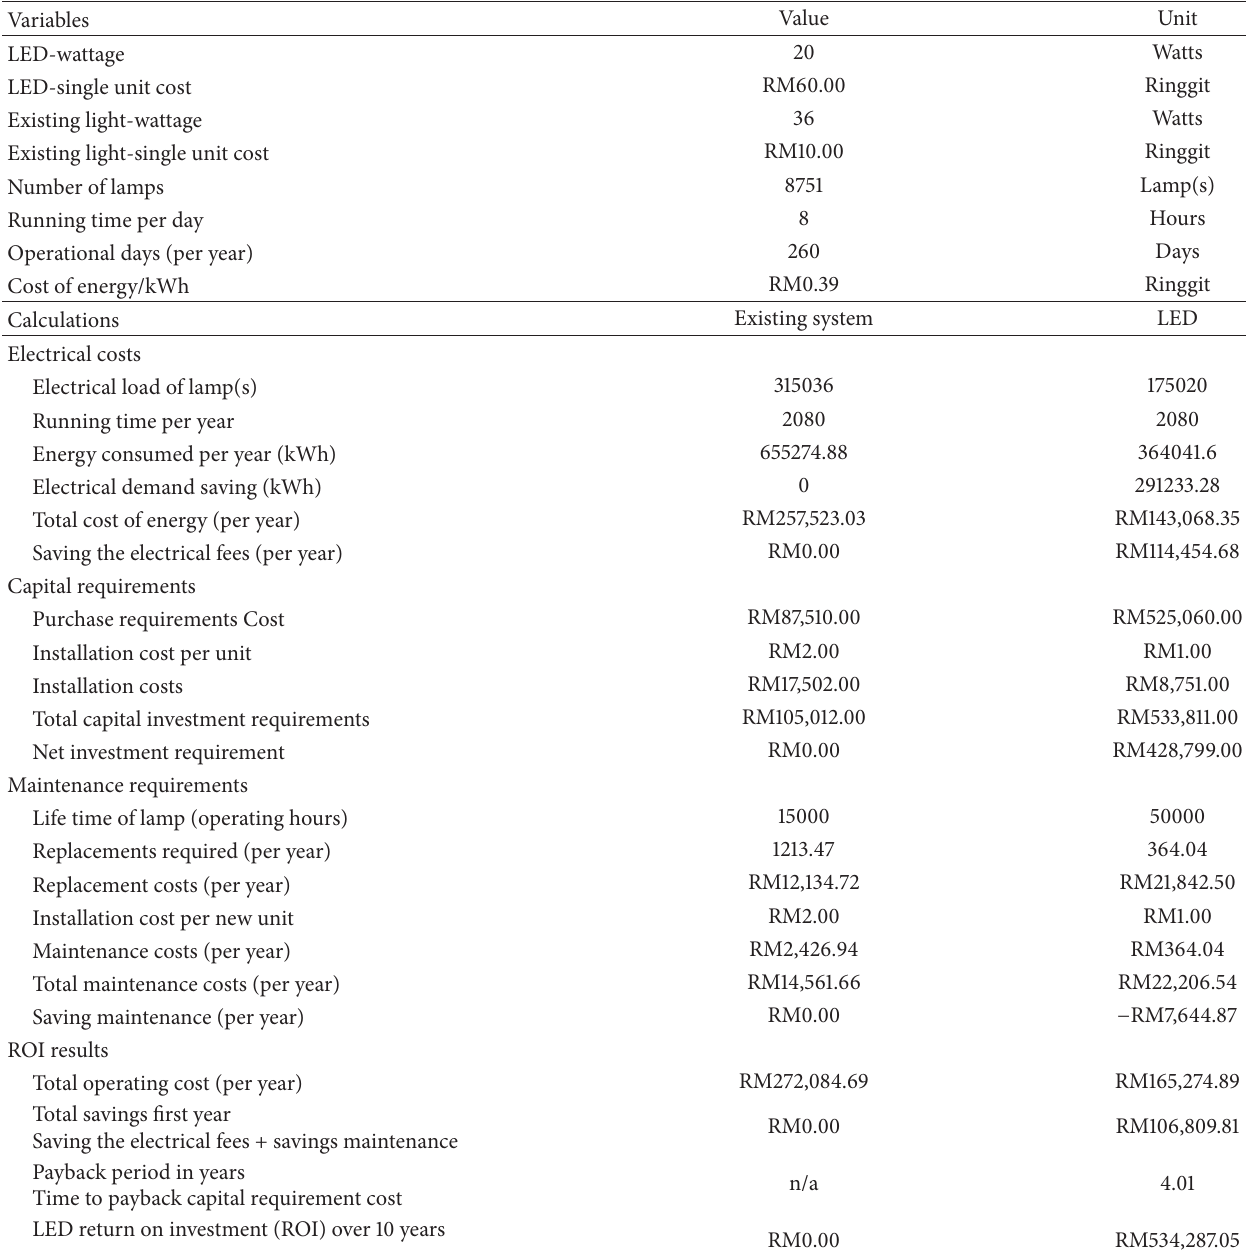
Table 6: LCC analysis for the 20 W LED tube replacing Philips 36 W fluorescent